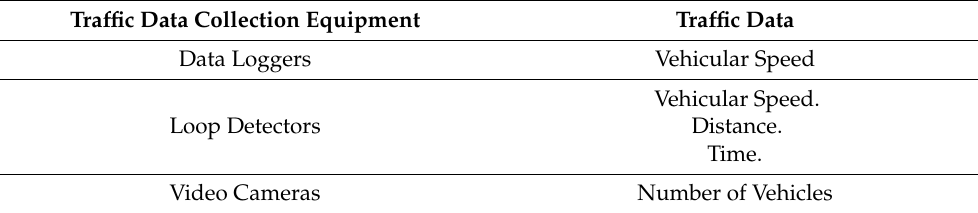
Table 3. Collection of Traffic